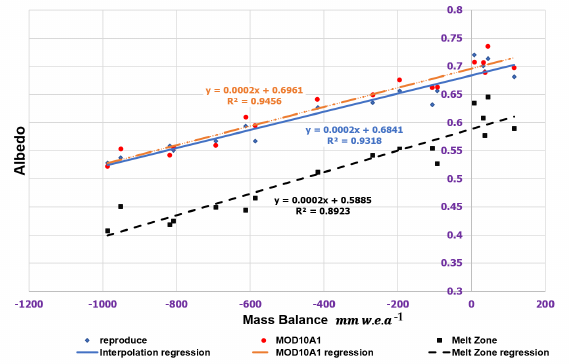
Figure 4. Least squares regression results of several average albedo data against mass balance. The colors of the regression lines correspond to the respective equations. The orange solid circles represent MOD10A1 average albedo of White Glacier. The blue diamond-shaped blocks are data of average interpolation albedo. The black rectangular blocks indicate average albedo data extract from ablation zone of White Glacier.